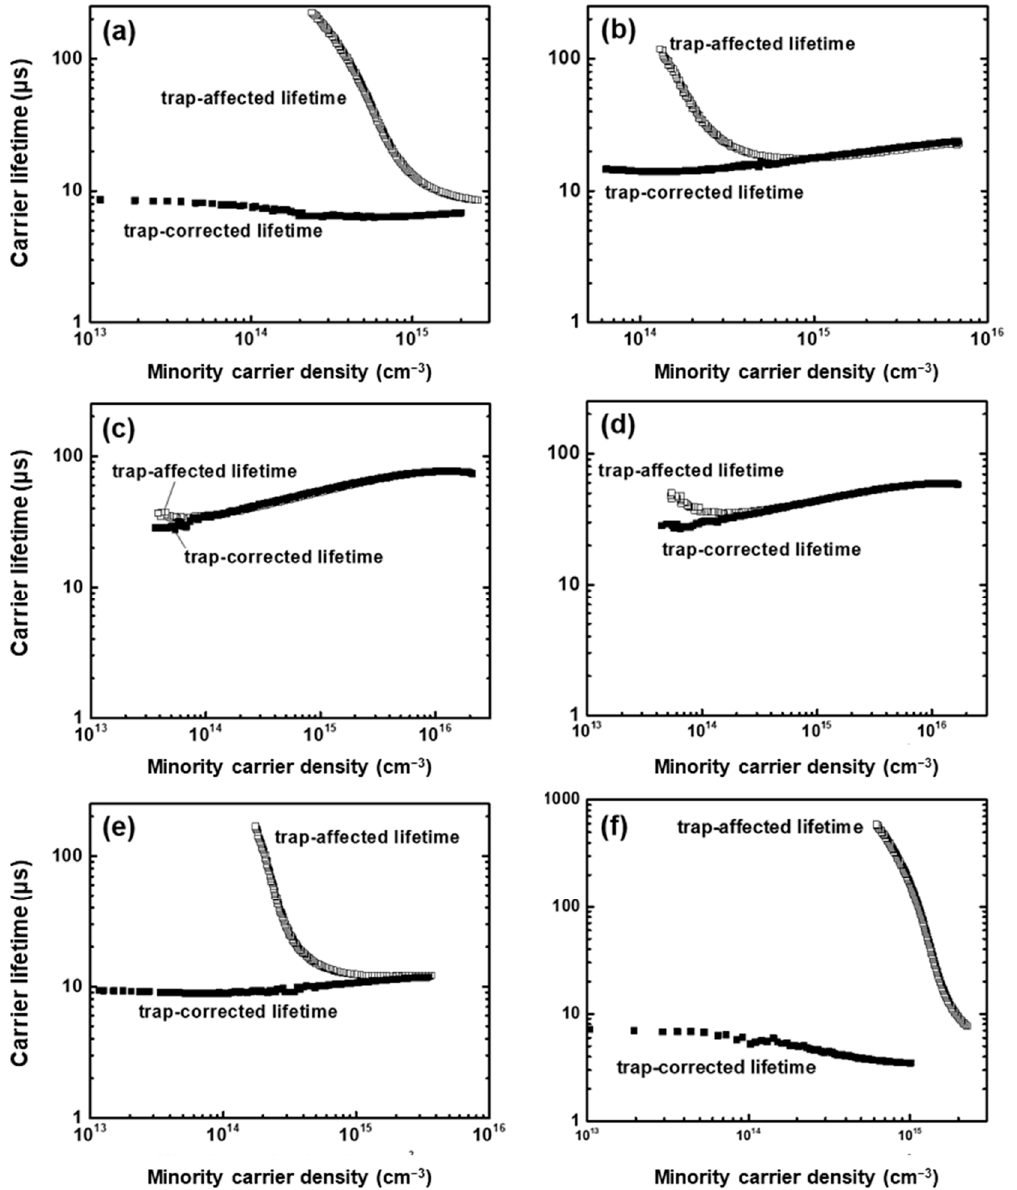
Figure 3. Comparison analysis results of the trap-affected carrier lifetime (measured data) and trap-corrected carrier lifetime at ( a ) 0 °C (initial), ( b ) 450 °C, ( c ) 550 °C, ( d ) 650 °C, ( e ) 750 °C, and ( f ) 850 °C.